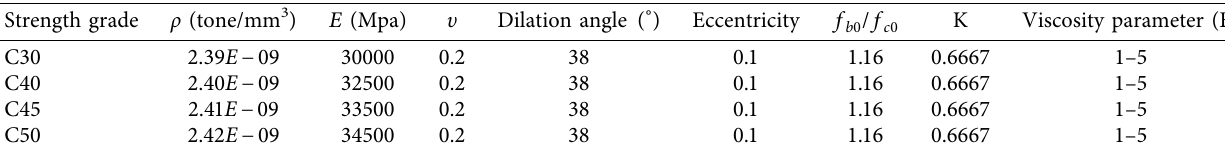
Figure 8: Constitutive laws for the CDP model. (a) Compression. (b) Tension. Table 2: Material parameters for the CDP